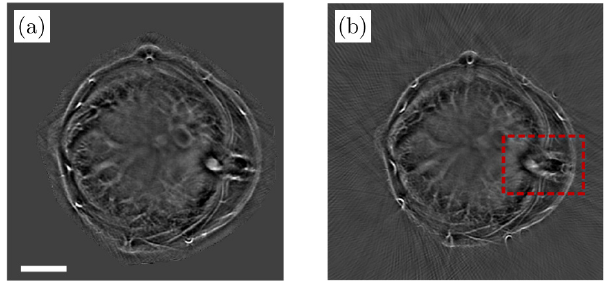
Fig. 7. PA images of a mouse liver reconstructed by the fea- ture coupling method (a) and the half-time back projection method (b). The image in (a) has no splitting artifacts, which are present in (b). Scale bar: 5 mm. Reproduced with permis- sion from Ref.